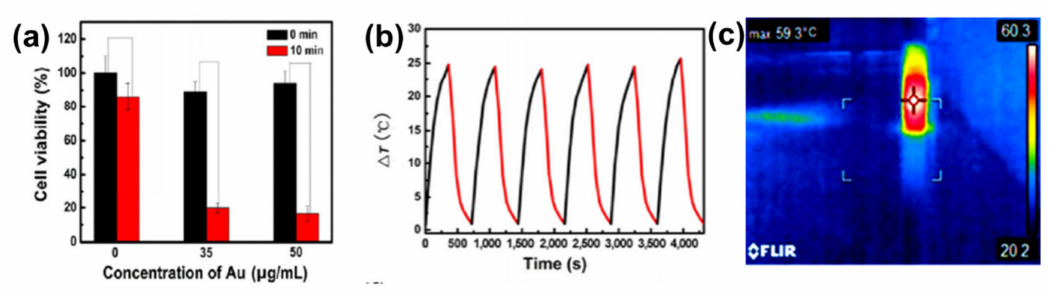
Figure 9. ( a ) Phototoxicity assay of SW1990 cells in the presence of di ff erent amounts of GO–PSS–AuNRs with or without laser irradiation (808 nm) for 10 min. ( b ) Photothermal profiling of on and o ff cycle of GO–AuNRs (50 µ g / mL) for 4000 s. Adapted from [38], with permission from Springer